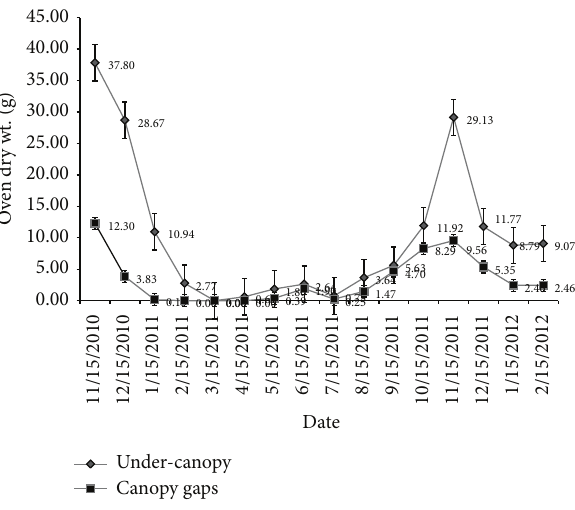
Figure 3: Litter fall patterns of S. sebiferum in the marked